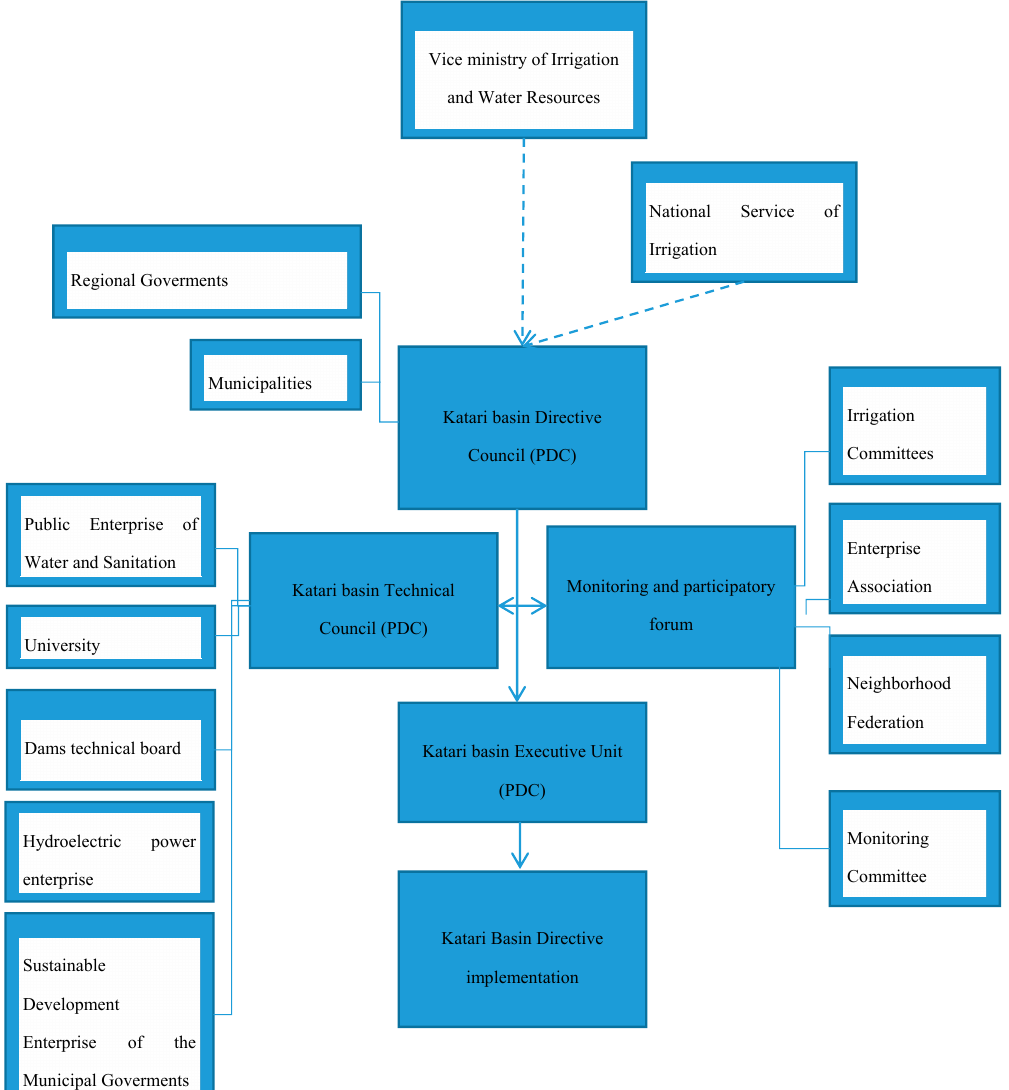
Figure 3. KRB Institutional Structure from 2010 Katari Basin Director Plan.